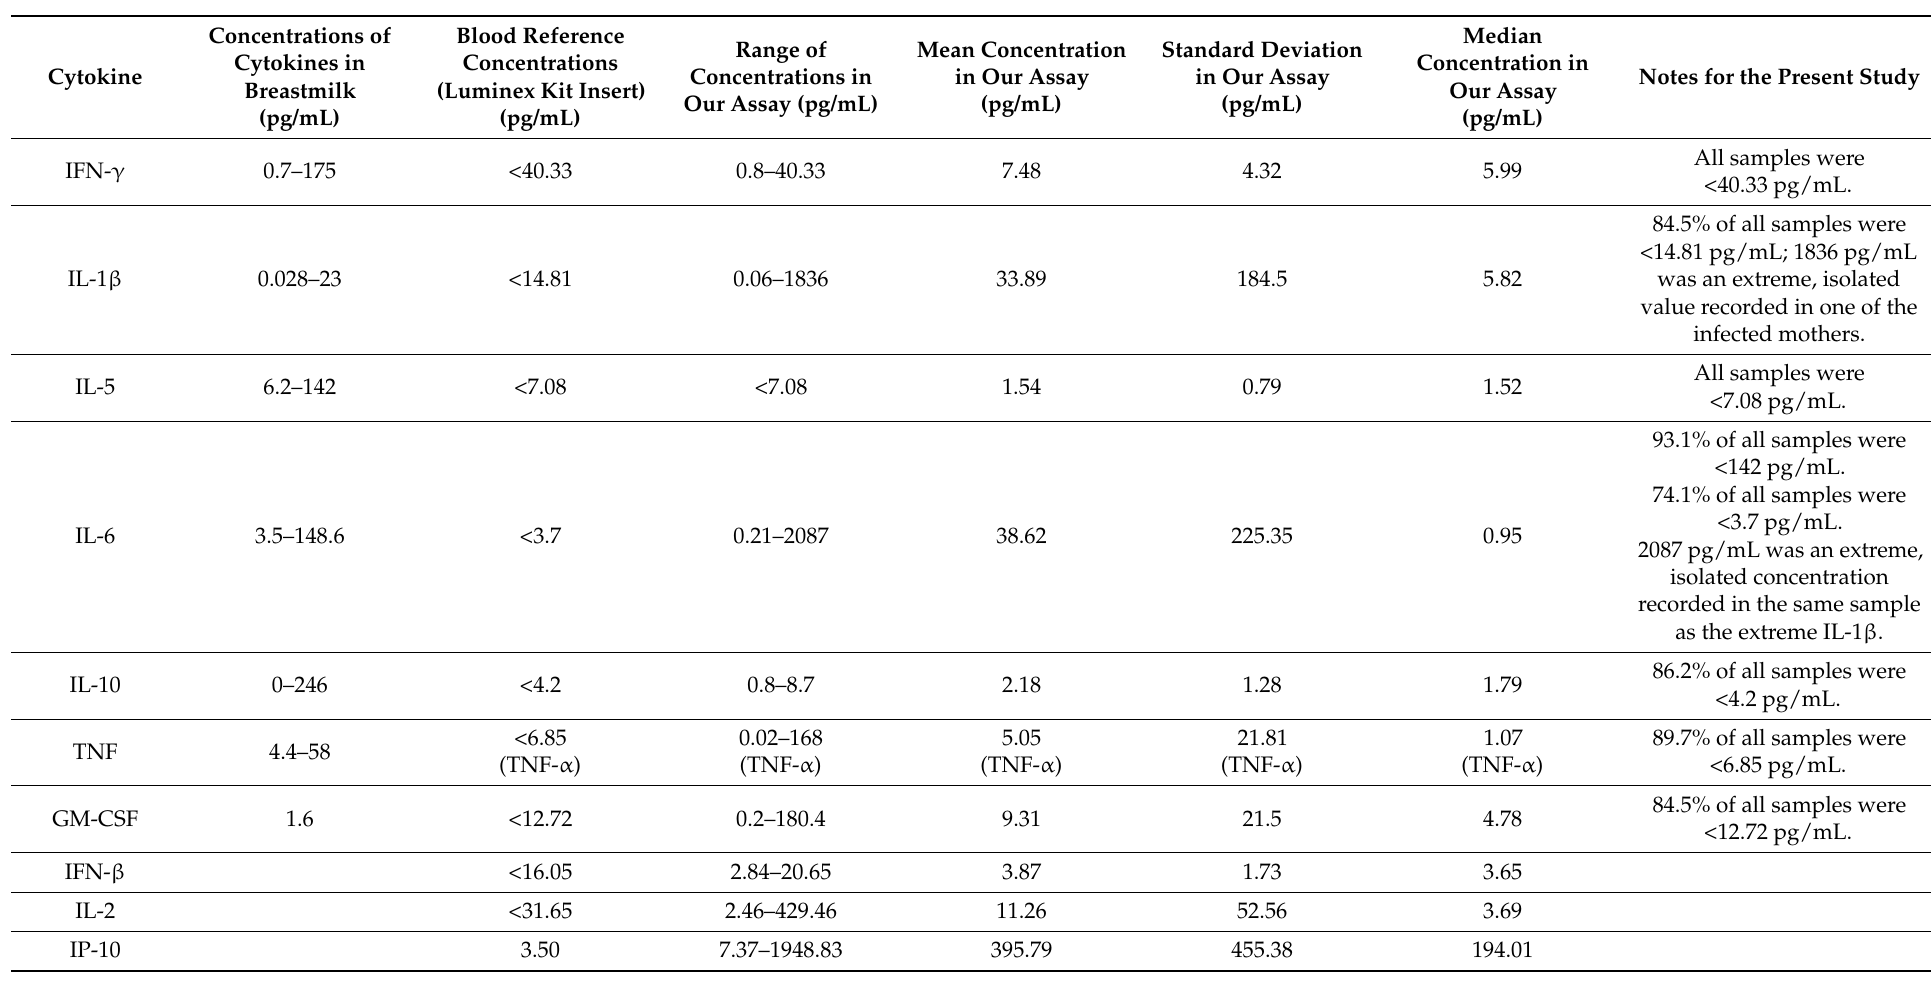
Table 1. Comparison of the cytokine concentrations excreted in human breastmilk as found in the literature with the reference values of the test kit and the range of concentrations, mean concentration, standard deviation and median obtained in the present